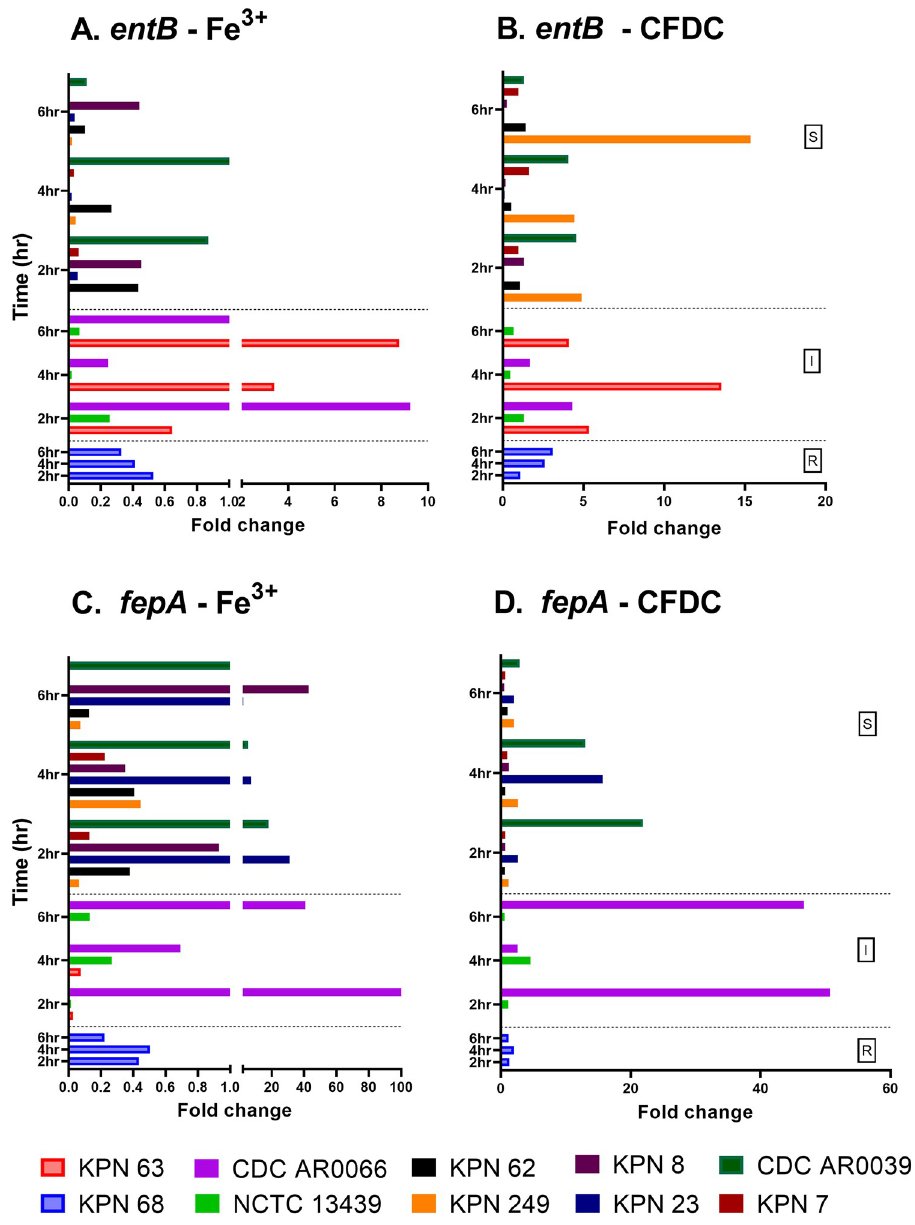
Fig 3. Gene expression of enterobactin ( entB ) and its receptor ( fepA ) in strains overtime in different media. Fold changes of expression were calculated for strains grown in different media by comparing the expression of each gene for bacteria treated with CFDC or grown in iron enriched media to the expression of the same gene at the same time point when the bacteria were grown in iron depleted media.